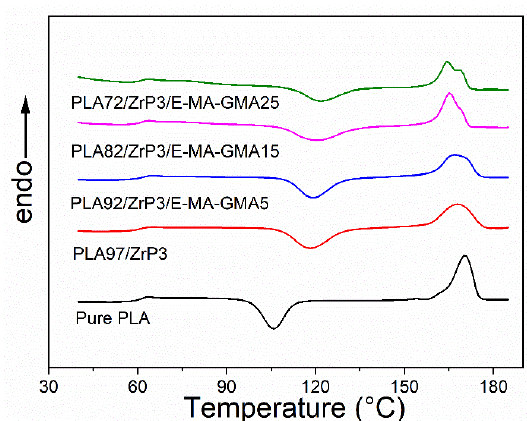
Figure 6. DSC curves of melting for pure PLA, PLA/ZrP, and PLA/ZrP/E-MA-GMA nanocomposites. Table 2. The T g , T cc , T m , ∆ H cc , ∆ H m , and χ c of PLA, PLA/ZrP and PLA/ZrP/E-MA-GMA nanocom-